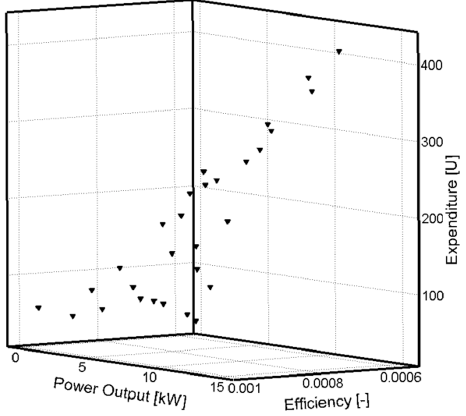
Figure 2. The Pareto front of the Kerman power plant.